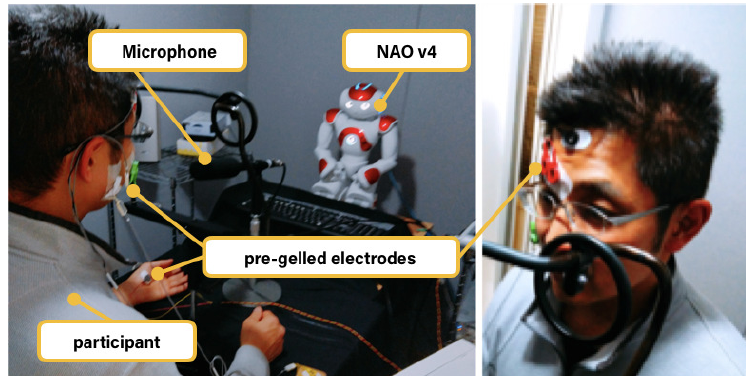
Figure 3. Photograph of the experimental setup. Participants read dialog scenarios in the presence of the Nao robot v. 4. The participant’s voice was recorded using a microphone, and the facial electromyography and skin conductance level were recorded using electrodes. The subjective responses of the participants were also assessed using